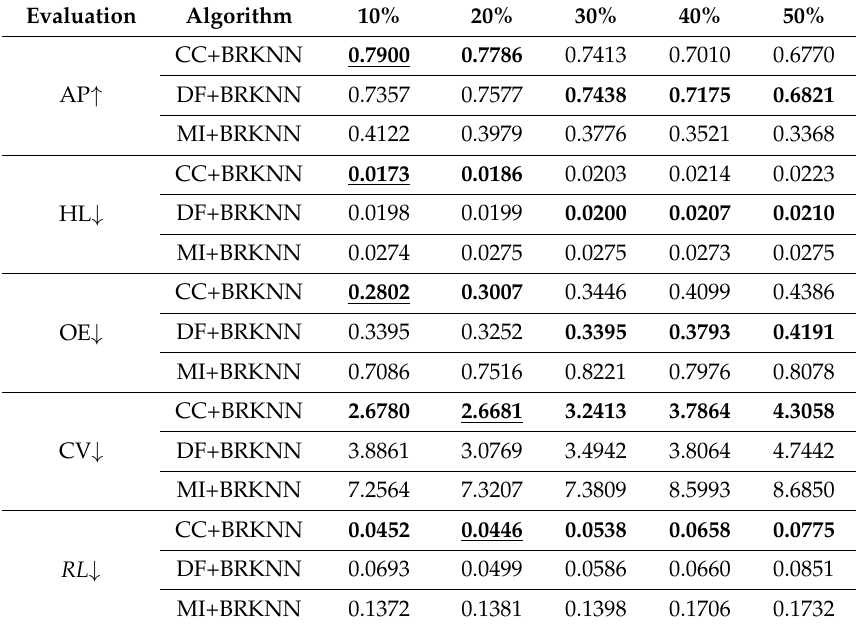
Table 9. Comparison of classification performance on Medical data